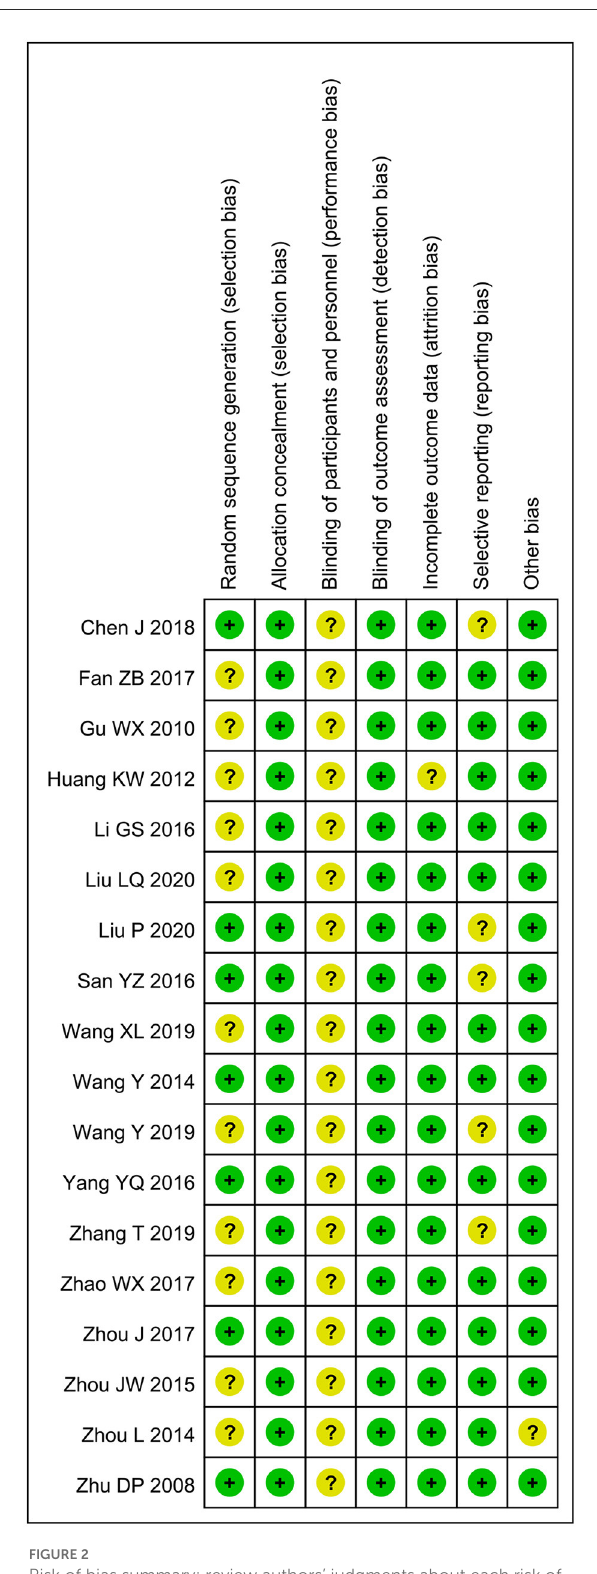
FIGURE2 Risk of bias summary: review authors’ judgments about each risk of bias item for each included study: low (green), unclear (yellow), and high